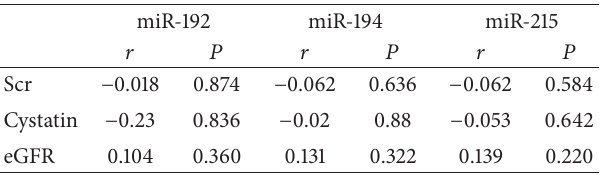
Table 3: Correlations between urinary EV miRNAs levels and renal function parameters in T2DM patients with normoalbuminuria ( 𝑛 = 30 ) and microalbuminuria ( 𝑛 = 30